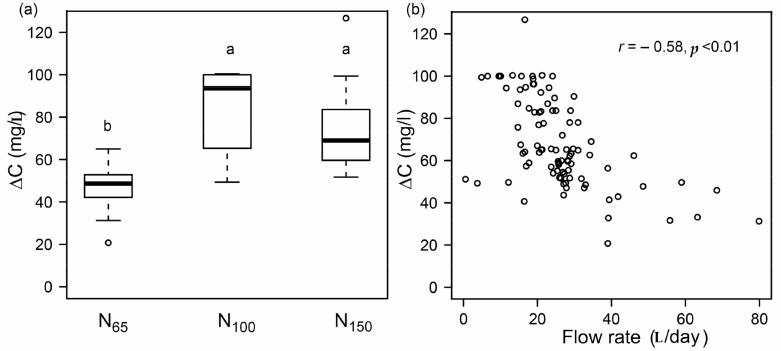
Figure 5. Boxplot of ( a ) ∆ C (difference between nitrate input and effluent concentrations) under different supplied nitrate concentrations (N 65 , N 100 , N 150 ) and ( b ) scatter plot of flow rate (L/day) against ∆